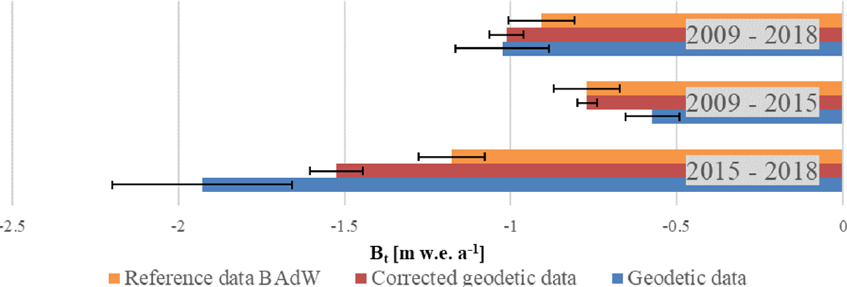
Figure 8. Comparison between geodetic mass balances (blue) and glaciological mass balances (orange) for the investigation periods. Red bars visualize corrected geodetic data.